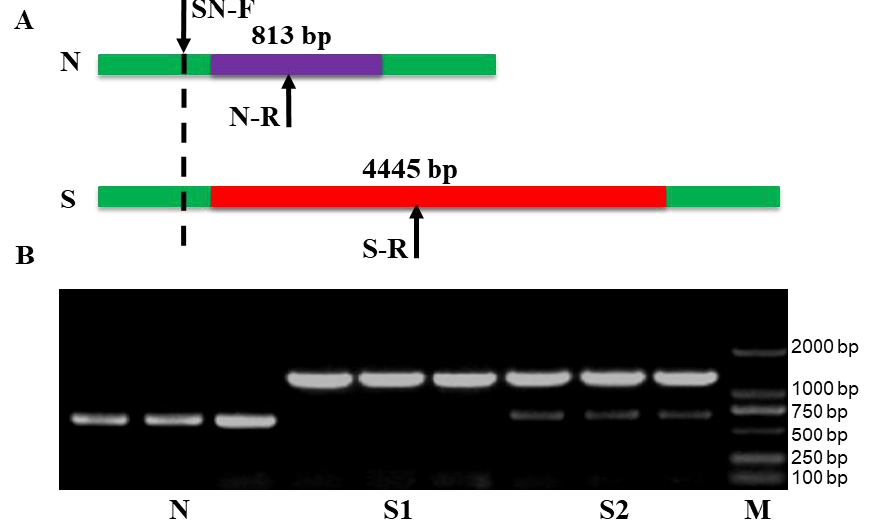
Figure 1. Identification of sterile cytoplasm S and fertile cytoplasm N of pol- and shaan- type CMS three-line hybrids by molecular markers. ( A ) The design schematic of S and N primers. ( B ) The identification results of S and N. The identical sequences of N and S genes are boxed in green. The inconsistent sequences of N and S genes are boxed in purple and red, respectively. N, fertile cytoplasm gene N; S, sterile cytoplasm gene S; M, DNA marker.